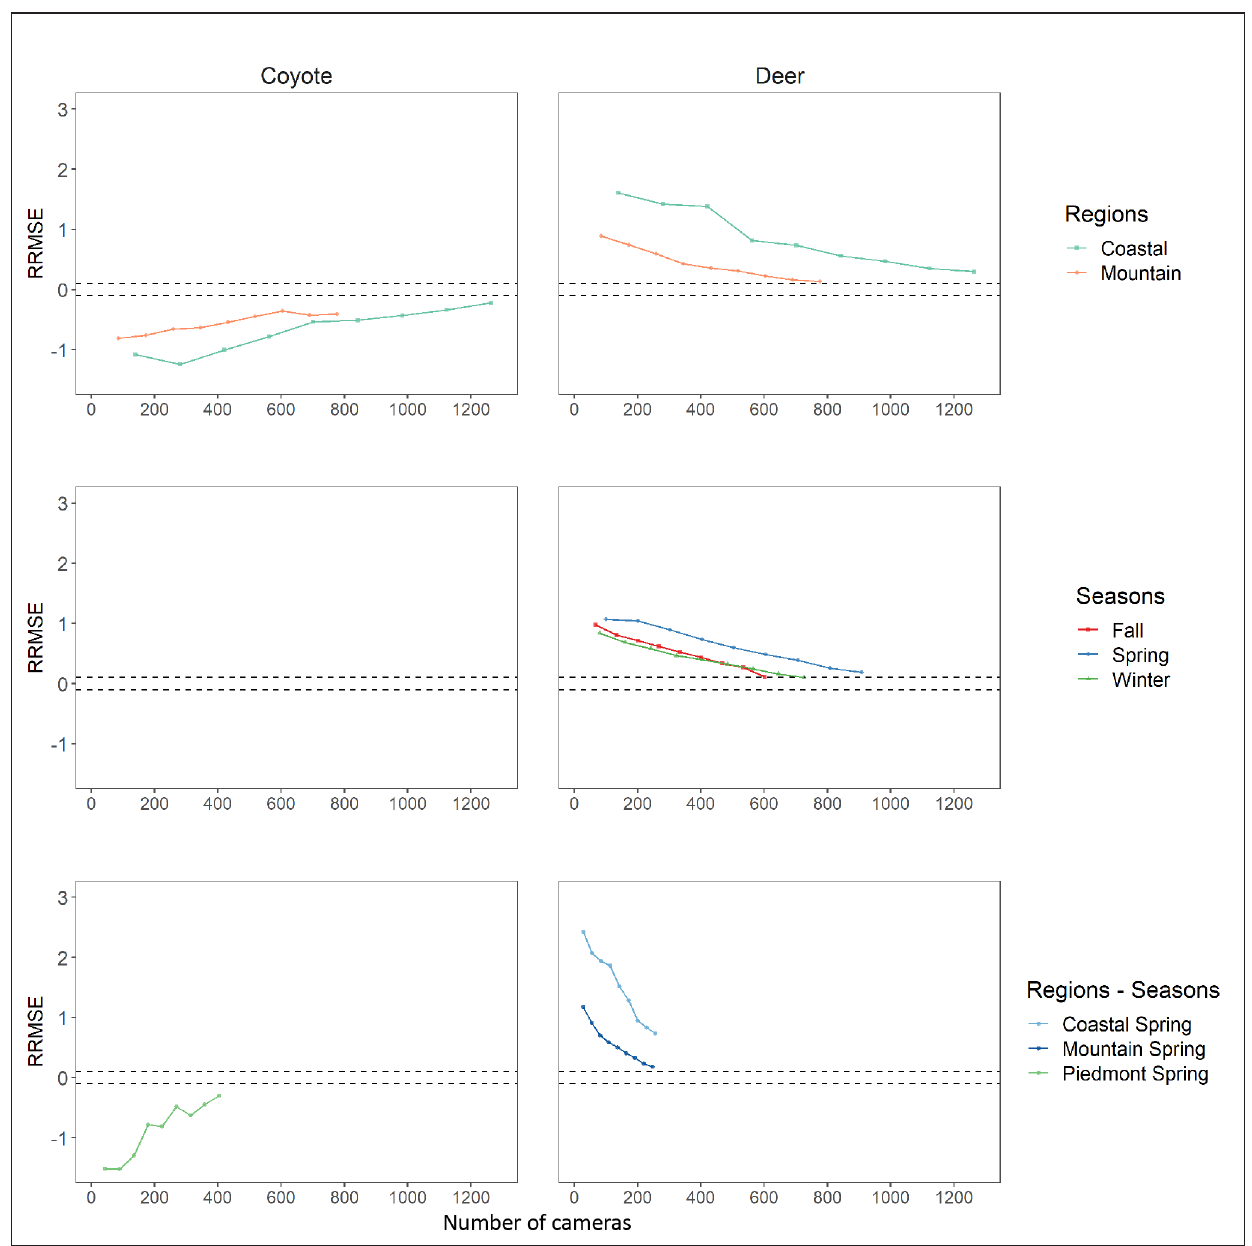
Figure 4 Graphs showing the changes in the relative error (relative root mean square error [RRMSE], a measure of how variable the estimates of occupancy were across the replicates) with larger sample size for estimated ecological relationships for agriculture land cover in occupancy models for coyotes and deer. Models were run across regions ( top ), seasons ( middle ), and regions-seasons ( bottom ). Only significant model effects are shown. Error estimates approached our 10% goal more rapidly with more restricted models (i.e., region- season) suggesting spatio-temporal variability in these relationships added variation to the larger-scale models. Full results for changes in error and bias of all covariates are available in Supplemental Figure